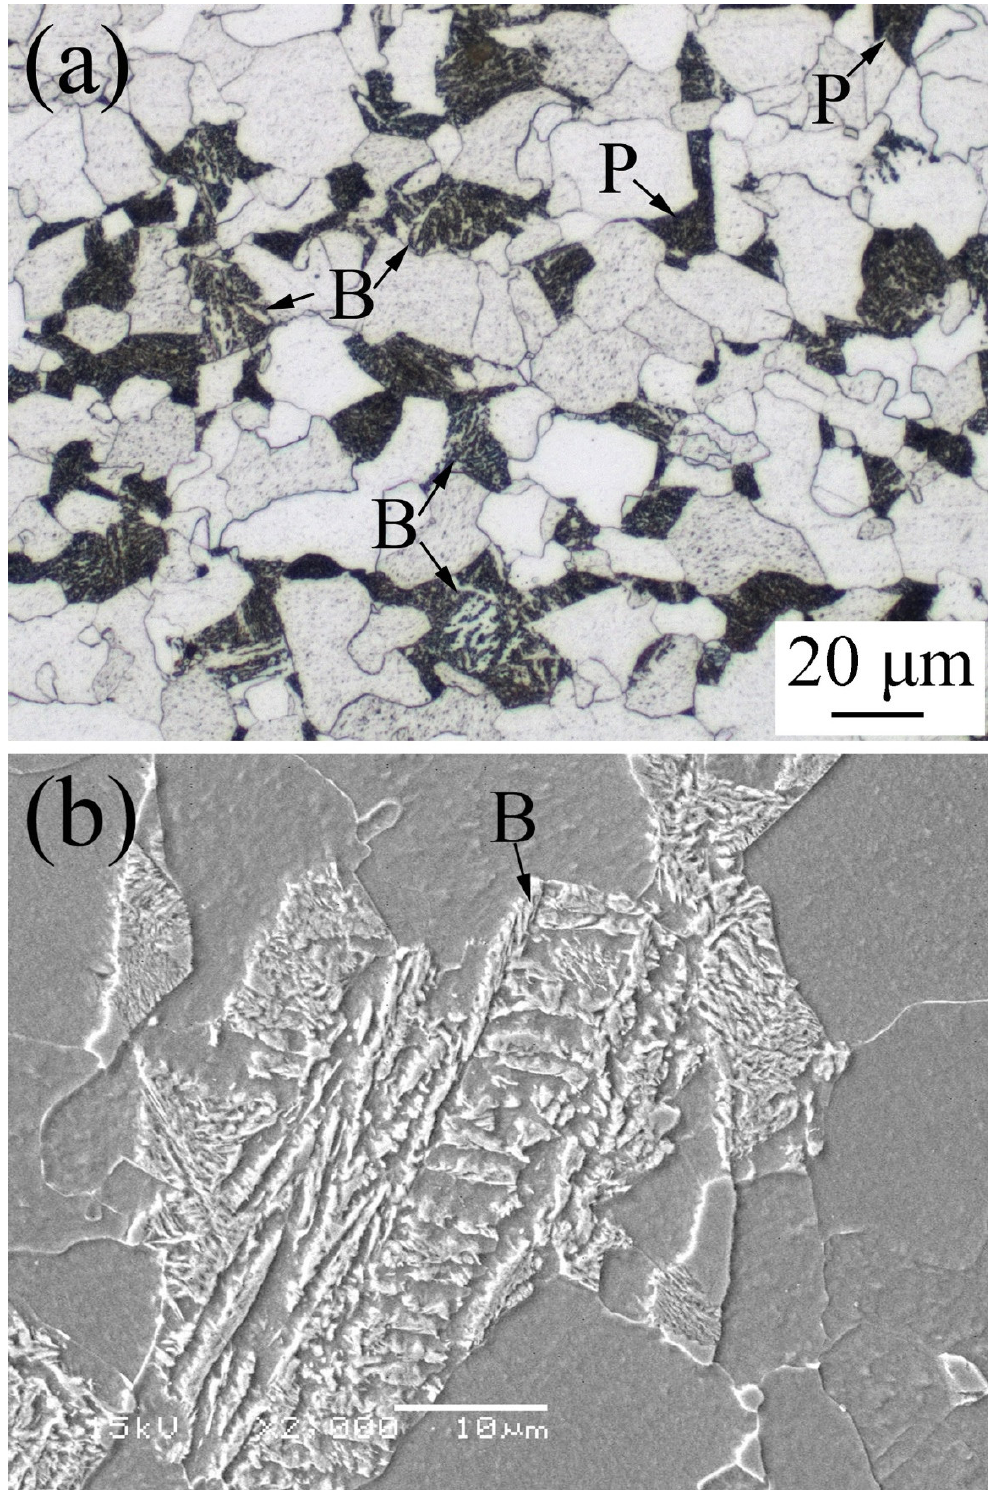
Figure 4. Microstructures of N2-HR steel after elevated-temperature tensile tests: ( a ) OM images, ( b ) SEM images.